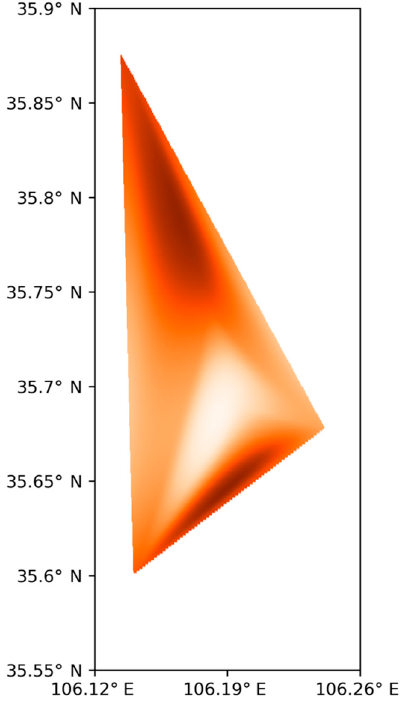
Figure 11. Heatmap of the Liupan Mountain